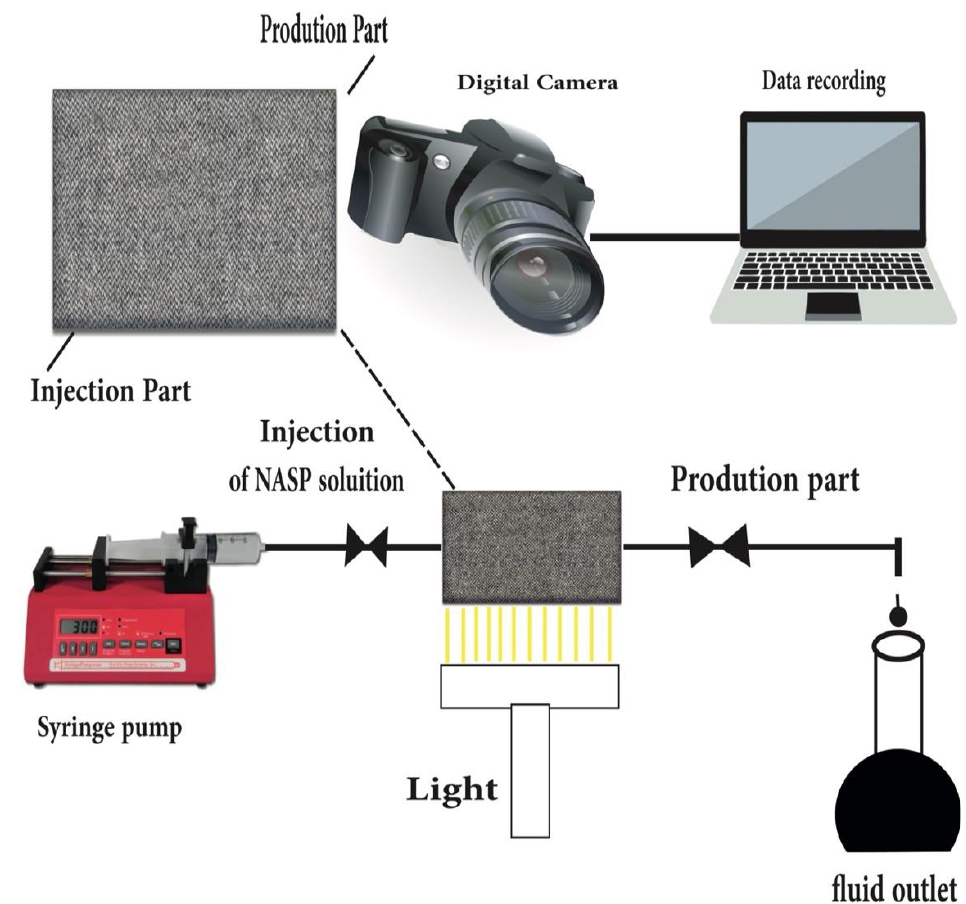
Figure 1. Future micromodel set up using NASP.